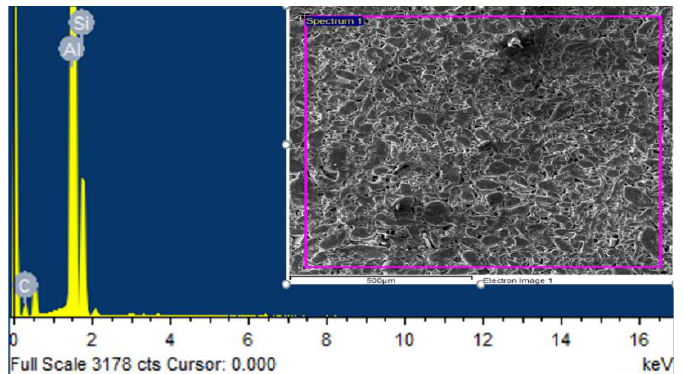
Figure 2. EDS spectrum of Al + 5%SiC reinforced composites. Table 4. List of elements found in the Al + 5%SiC reinforced composites.